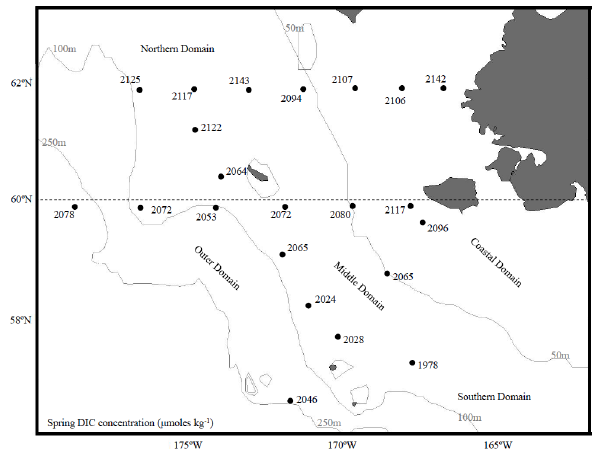
Fig. 3. Spring DIC concentrations (µmoleskg − 1 ) averaged over the upper 30m of the water column across the